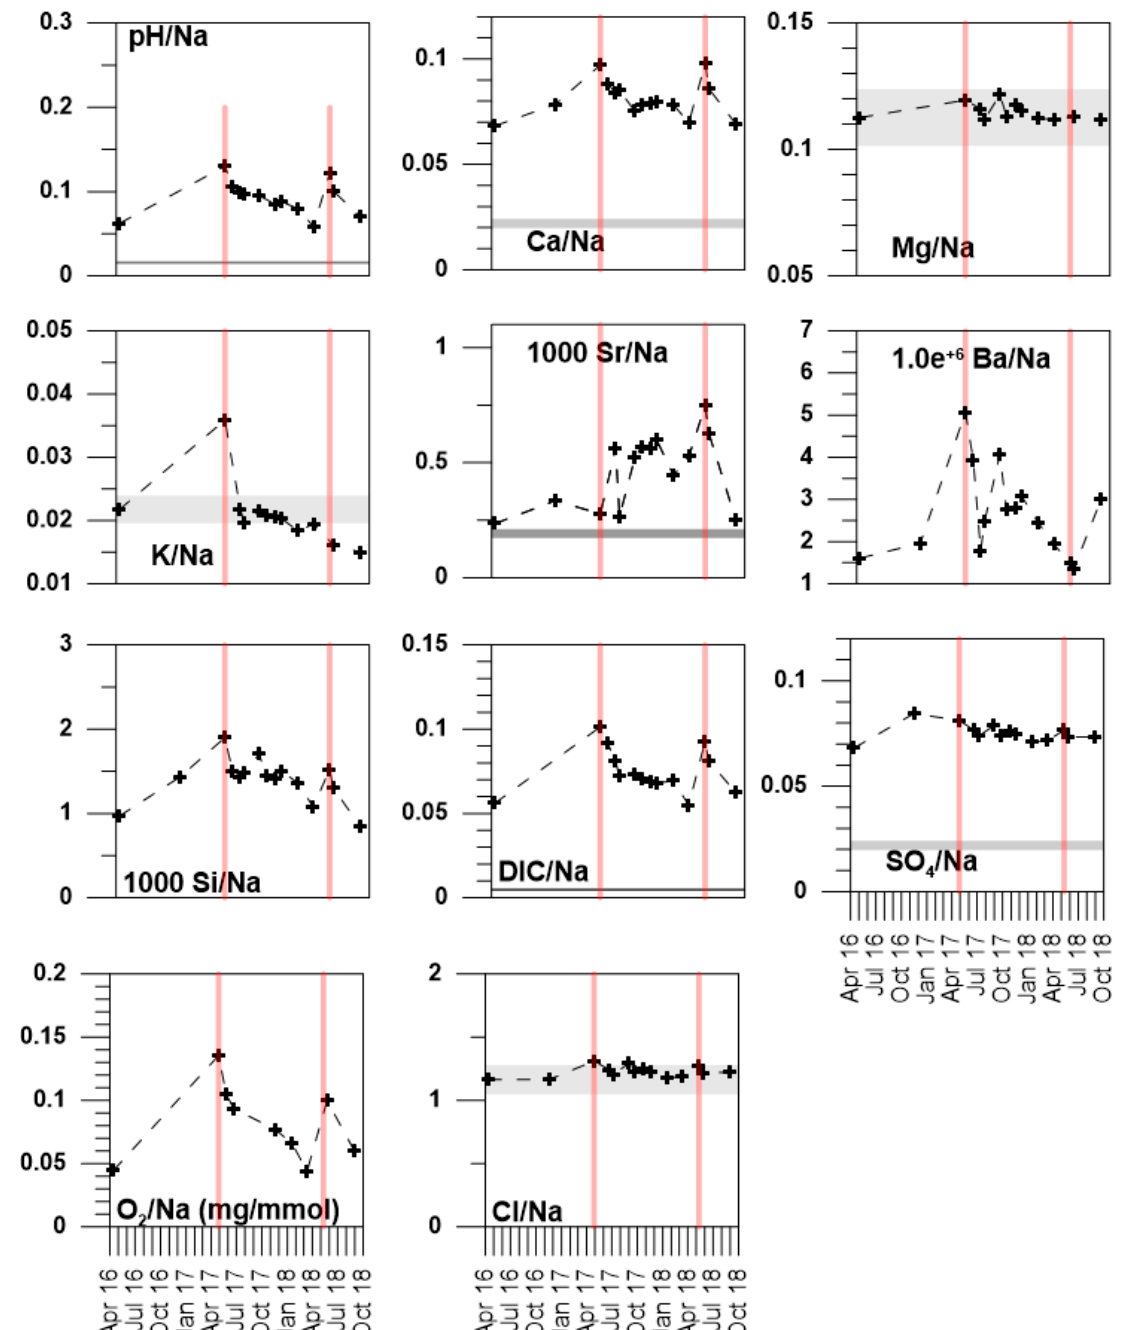
Figure 5. Na-normalized element concentrations of the karstic spring waters over time. The red vertical lines outline the salinity minima on April 28, 2017 and on May 11, 2018. The grey shaded areas correspond to concentration values within ± 10% of those for standard seawater [33]. The retained values used to generate the grey areas for standard seawater are 8.2 for pH and 2.3 mmol/L for DIC. No standard concentration for Si, Ba, and O 2 in seawater can be defined, although a Ba concentration value of 40 nM is characteristic of the Mediterranean sea [38].